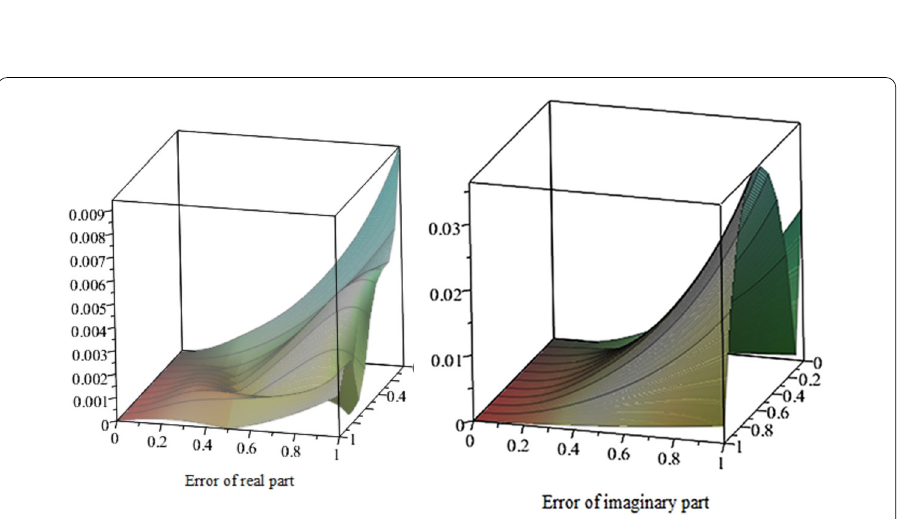
Figure 3 The plots of error of u ( x , t ) and v ( x , t ) for Example 5.1 with the noisy